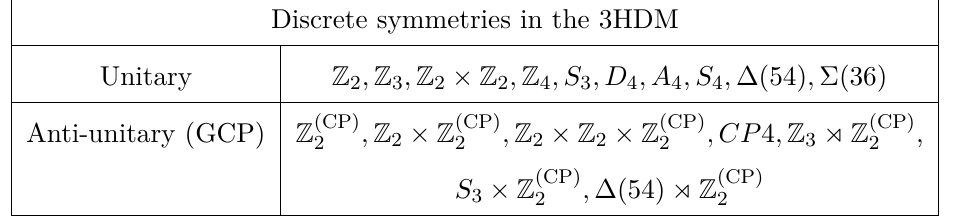
Table 1 . Full list of discrete symmetries in the 3HDM, where Z (CP)